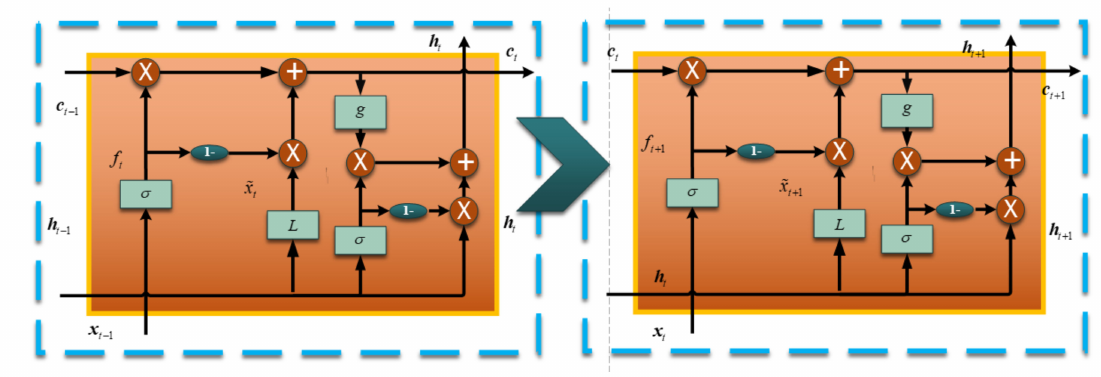
Figure 2. Working flow of two Simple Recurrent Unit–Recurrent Neural Networks.